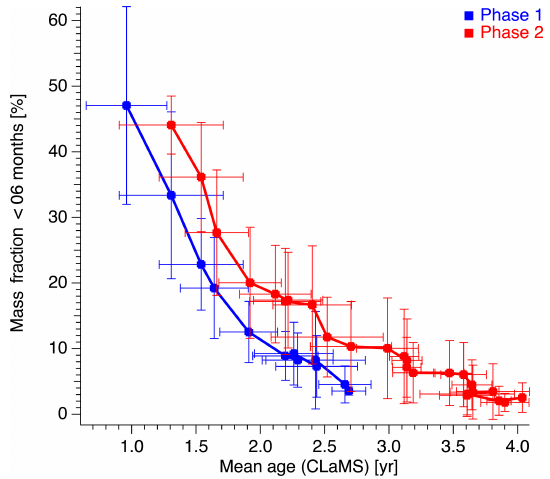
Figure 11. Mean age versus air fractions with transit times < 6 months from the age spectra simulated by CLaMS for phase 1 (blue) and phase 2 (red). Each data point is binned in steps of 5ppb V N 2 O. The variability in each bin is given by the vertical and hori- zontal lines.